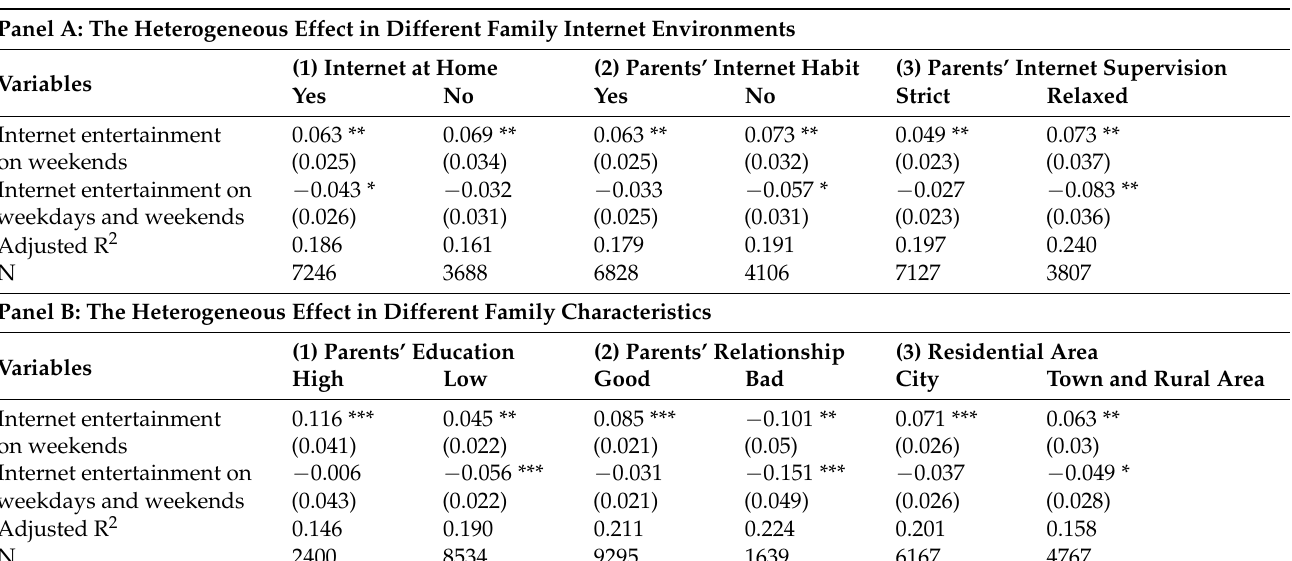
Table 3. Heterogeneous analysis